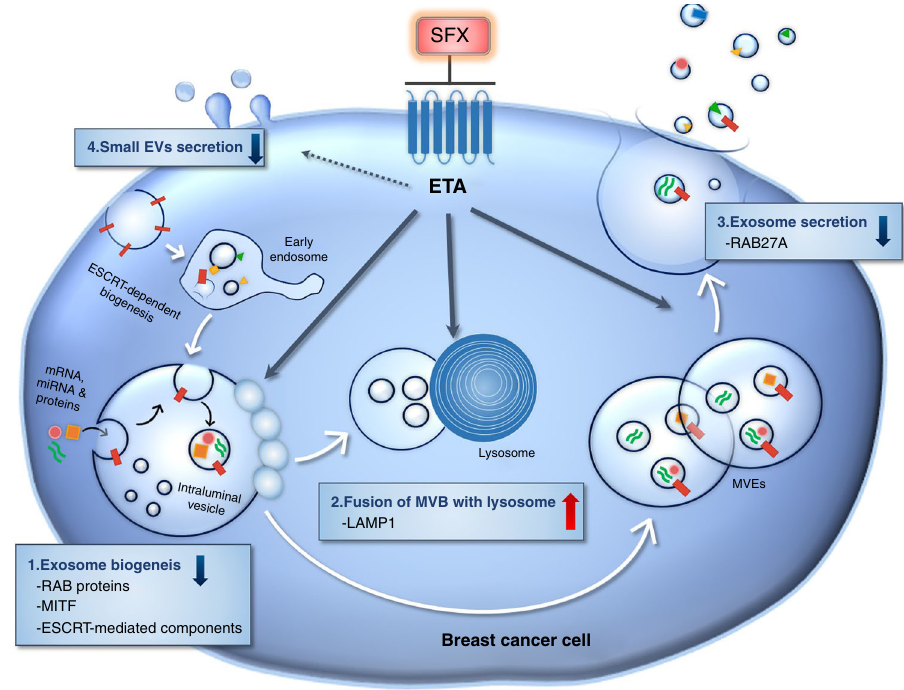
Fig. 8 Proposed model for SFX-mediated inhibition of sEV secretion in MDA-MB231 cancer cells. SFX, through ETA binding and subsequent interference, reduced the expression of proteins involved in the sEV biogenesis and secretion, increased the fusion of MVEs with lysosomes, and fi nally decreased the number of secreted sEV from breast cancer